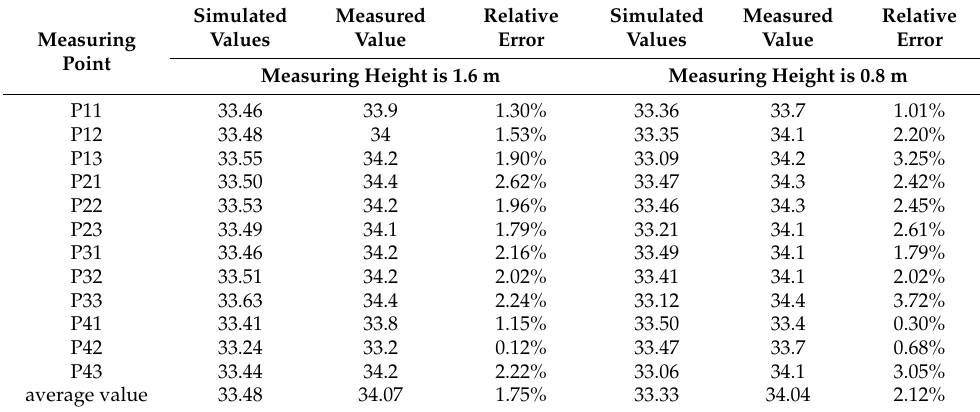
Table 4. Measured Value and Simulated Value of Each Temperature Measuring